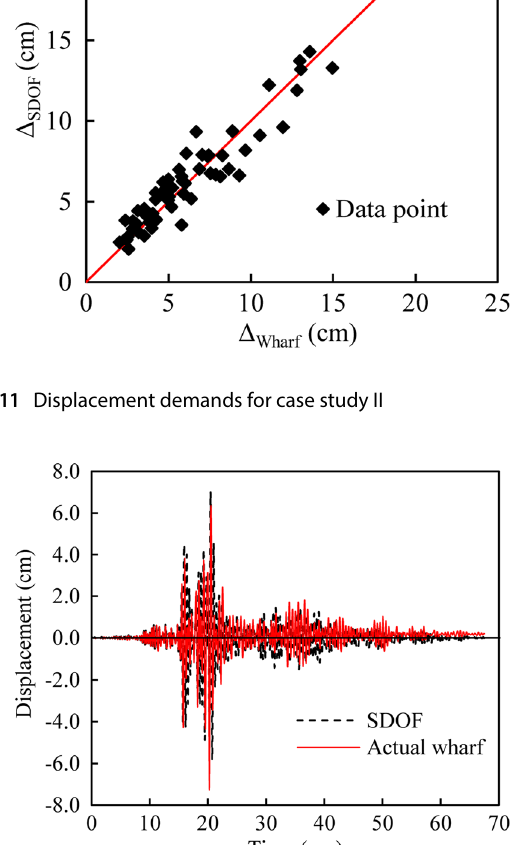
Fig. 12 Displacement time histories of SDOF system and actual wharf under a certain ground motion for case study